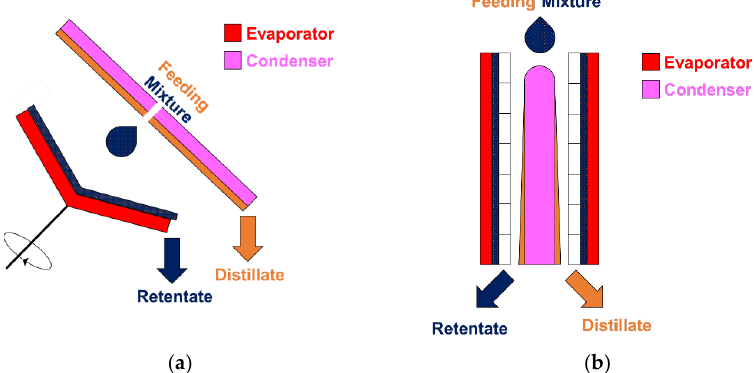
Figure 1. Simple schematic figure of ( a ) centrifugal distillator ( b ) falling film distillator. The falling-film molecular distillation was used to refine cold-pressed rapeseed and sunflower oils with evaporation temperature at 210 °C, and vacuum pressure at 40 Pa [19]. The process was able to reduce FFA content and peroxide value of rapeseed oil to 0.05 wt.% and 0.35 mmol kg − 1 , respectively. Sunflower oil was also processed to low FFA con- tent and peroxide value at 0.04 wt.% and 0.17 mmol kg −1 , respectively. The centrifugal molecular distillation was used to recover decanoic acid from cuphea fatty acids, using evaporation temperatures of lower than 110 °C and pressures of 0.08 – 0.40 Pa [20]. The fatty acid could be recovered in distillate steam, and the purity increased from 96.0 to 99.8 wt.%, by two passes. The optimization of molecular distillation in food processing have been recently discussed to improve its performance. The conjunction of the response sur- face method and an artificial neural network was utilized to optimize the enrichment pro- cess of terpene alcohol by molecular distillation [21] under the conditions of evaporation temperature between 60 and 110 °C, condensation temperature from 2 to 18 °C, and wiper rotational speed of 100 to 600 rpm as optimization targets. The wiper rotational speed showed less influence, compared to evaporation and condensation temperature. Another approach to explain the mechanism of molecular distillation is a mathematical model and simulation. The Direct Simulation Monte Carlo method was used to simulate a vapor flow in molecular distillation, which emphasized the importance of the difference between evaporation and condensation temperature [22]. A binary mixture of ethylhexyl phthalate and ethylhexyl sebacate was studied with evaporation temperature between 80 and 100 °C and condensation temperature from 0 to 20 °C to simulate vapor flow in a distance between evaporator and condenser surface ranging from 10 to 30 mm. The evaporation temperature, which was correlated with vapor pressure, showed more influence in the model as compared to condensation temperature. The model developed in ASPEN HY- SYS was investigated to study the influence of evaporation temperature, vacuum pres- sure, and feeding rate [23]. Beta-carotene, tocopherol, and FFA in palm oil were the target compounds. The authors suggested a significantly higher influence of the temperature and pressure over the feeding rate. Then, the response surface method was applied to optimize the process; the optimized temperature, pressure, and feeding rate were 147 °C, 0.7 Pa, and 1291 kg h −1 , respectively. To the best of our knowledge, the analysis of evaporation rate and mechanism of molecular distillation for edible oil processing have not been clarified yet. Therefore, in this study, a binary mixture of two components, soybean oil and oleic acid, was employed, and falling-film molecular distillation was investigated. A model to elucidate the evapo- ration mechanism was proposed, and simulation was performed in order to compare with the experimental results.